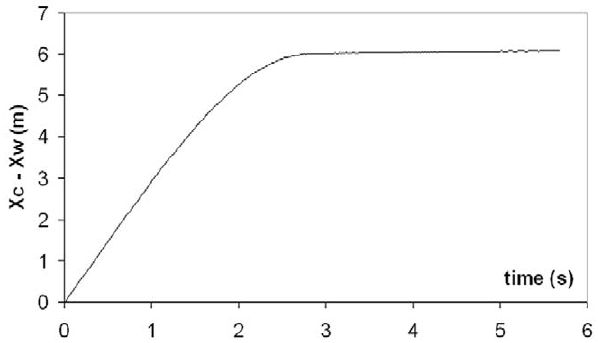
Figure 13. Lead slug location with respect to the TMJ. Simulated positions of the first-engulfed slug for a 20.2 m fin whale. Here the lead slug stops traveling beyond the time of maximum gape (i.e. after the 2.85 s mark), per Synchronized Engulfment. Note also that this slug can never travel past the umbilicus, or in other words, cover a distance exceeding L 0 – L jaw (=7.34 m in this case).